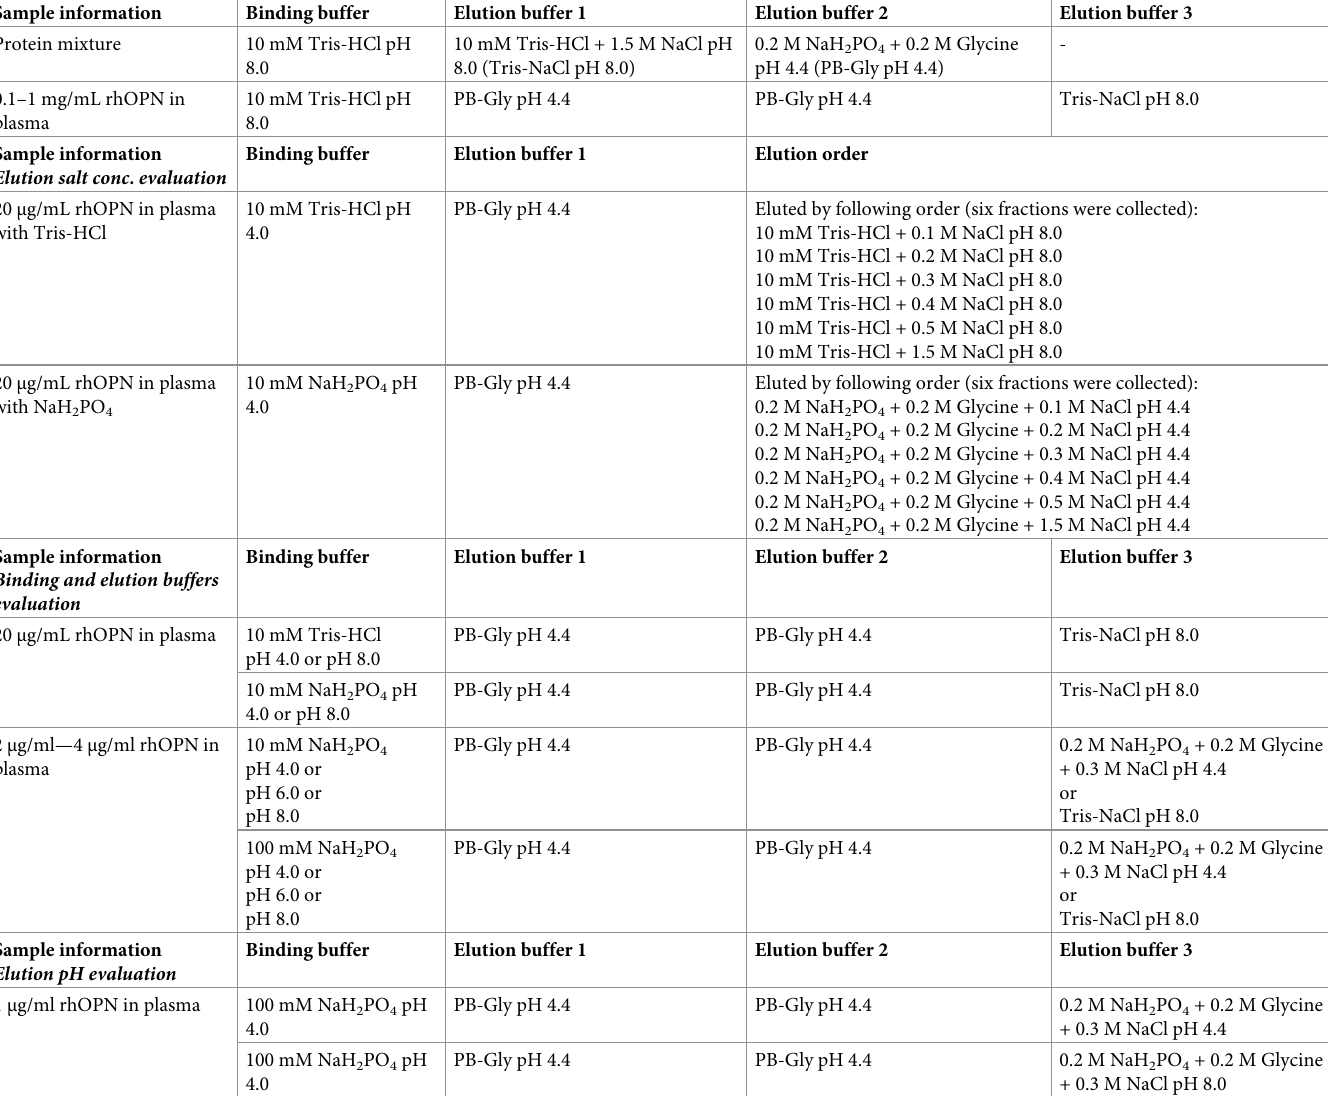
Table 1. Binding and elution buffers evaluated with protein mixture samples and rhOPN in human plasma